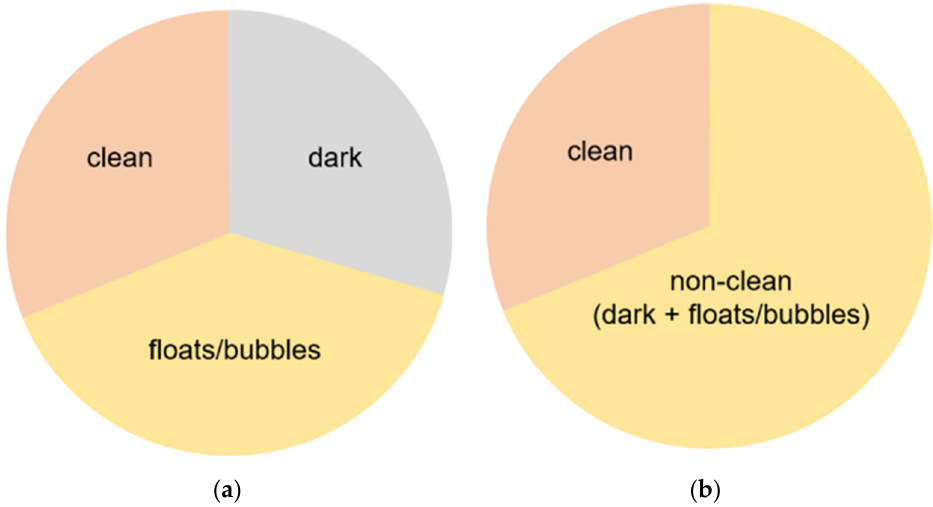
Figure 2. Schemes for each capsule endoscopy (CE) image class. Each color represents an individual region in a CE image. ( a ) 3-class: separate clean, dark, and floats/bubbles regions. ( b ) 2-class: Dark and floats/bubbles regions merged into a single class.